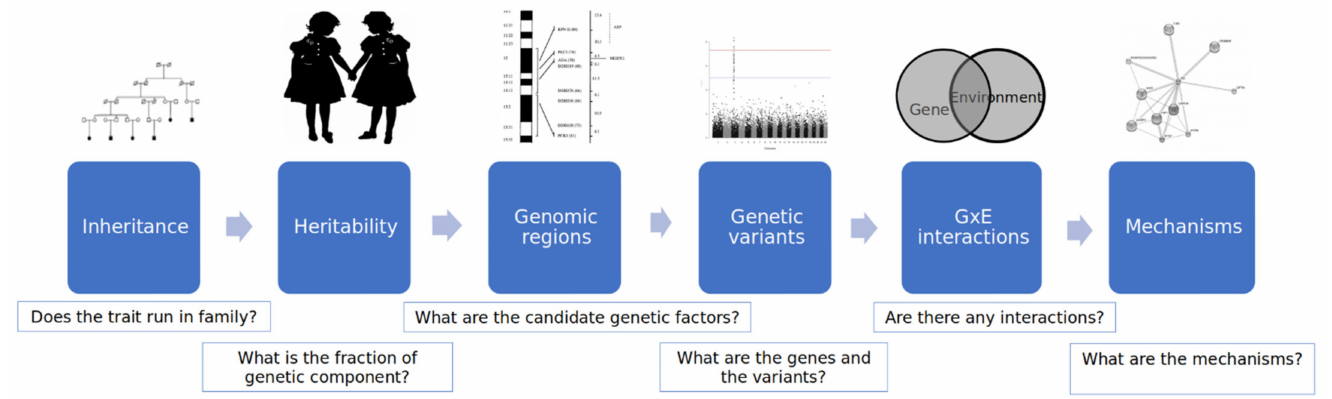
Figure 1. Genetic methods for the analysis of complex